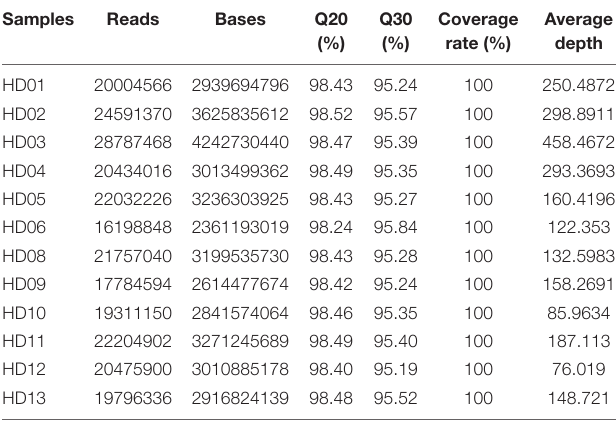
TABLE 2 | Statistical analysis of the clean data from 12 samples.